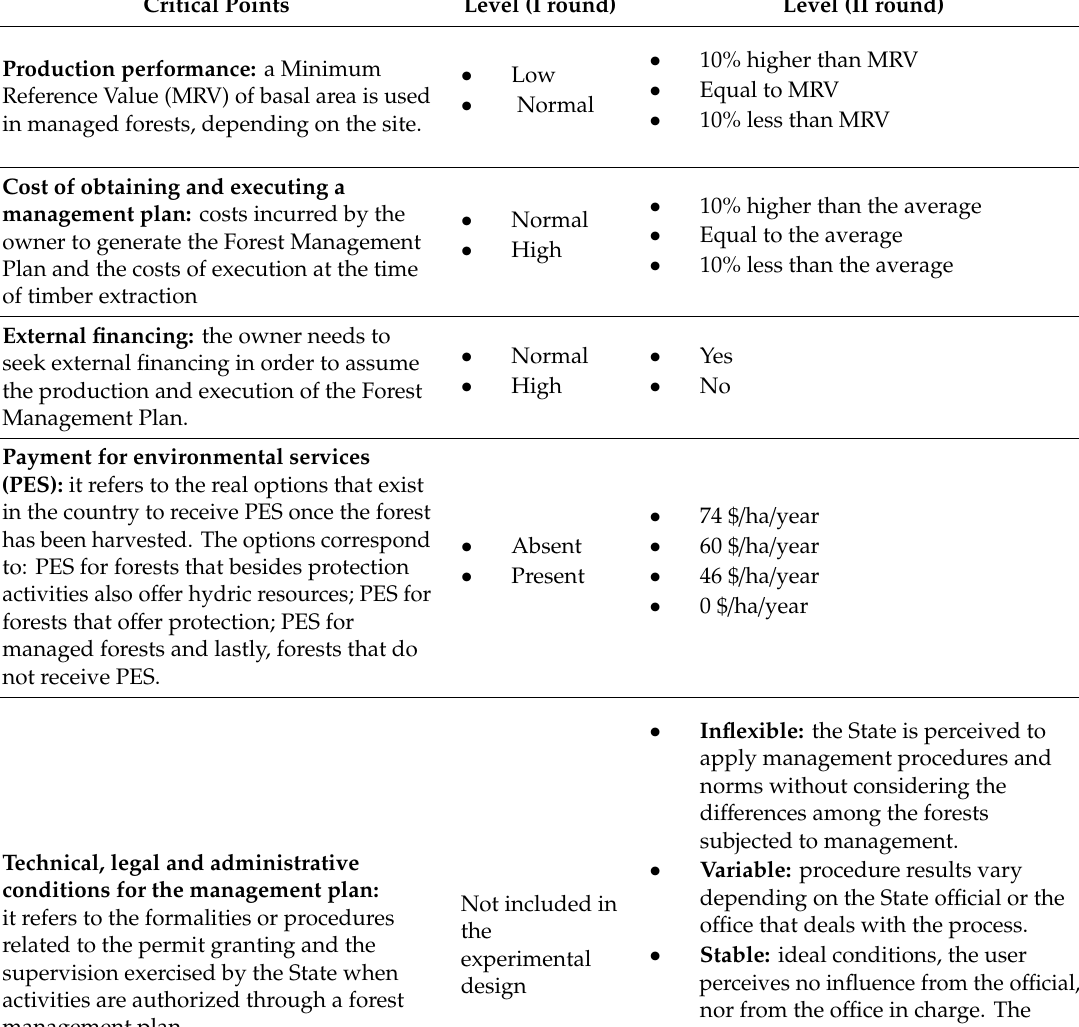
Table 1. Critical points and levels used for the choice experiment in the first and second round. Critical